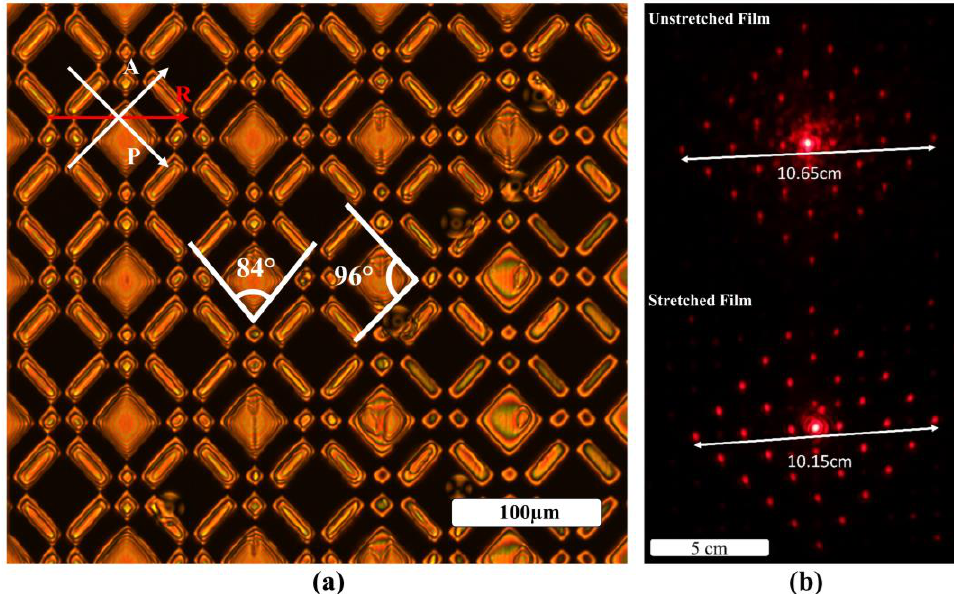
Figure 9. Demonstration of mechanical stretching of a free-standing laser written film with a 2D diffraction pattern in the far-field. ( a ) a POM image of a film (20 μm) with a laser written 6 × 6 2D Dammann grating in a rhombus shape. The dark regions correspond to the homeotropic aligned director locked-in using TPP-DLW at a voltage of 100 Vrms, while the bright regions correspond to the domains of the LC gel photopolymierzed using UV exposure without an electric field; ( b ) Far-field images of the change in the diffraction pattern in the replay field before stretching and when the film was stretched.